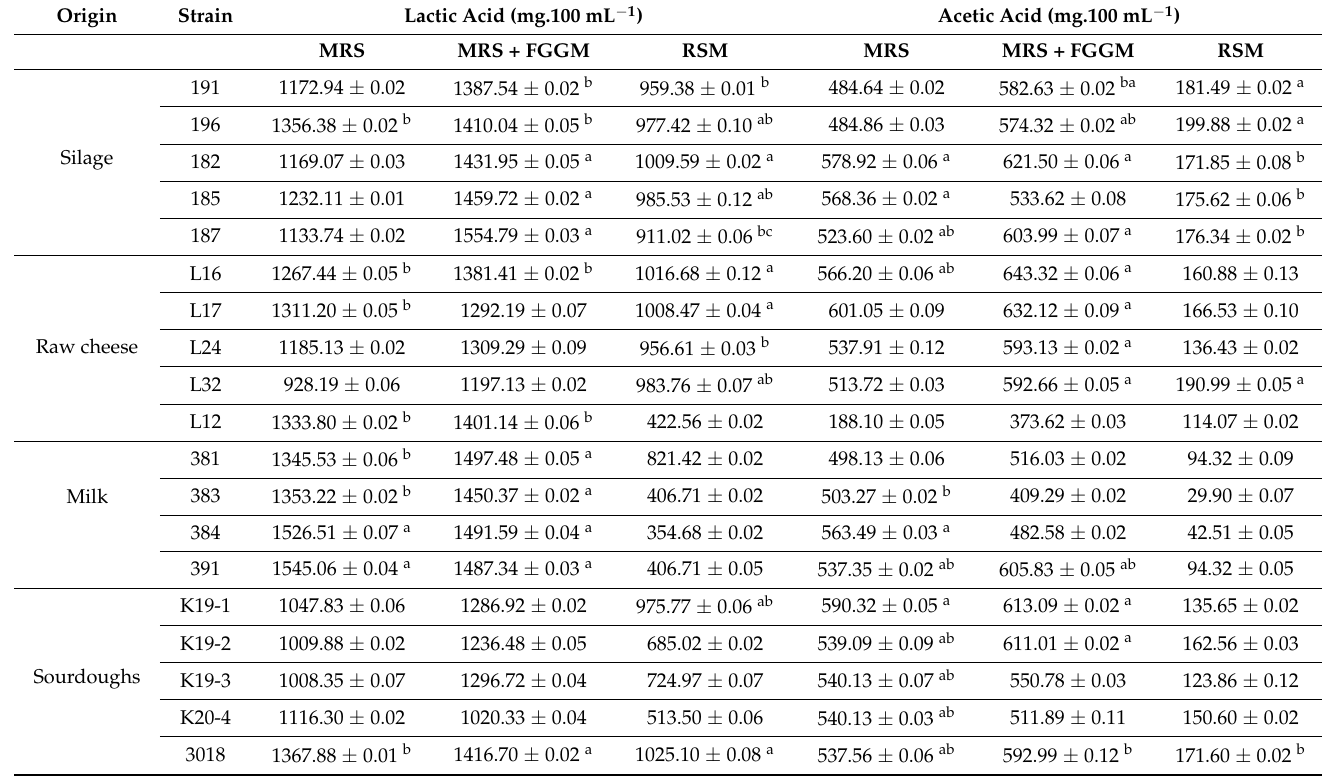
Table A1. Production of organic acids by strains of L. plantarum in different media. ANOVA, Statistica v. 12, Post Hoc Tukey’s HSD Test. The data represents logarithmically transformed index scale values, standard deviation (SD) and standard error of means (SEM). The index letters indicate the significant differences. Significant at α ≤